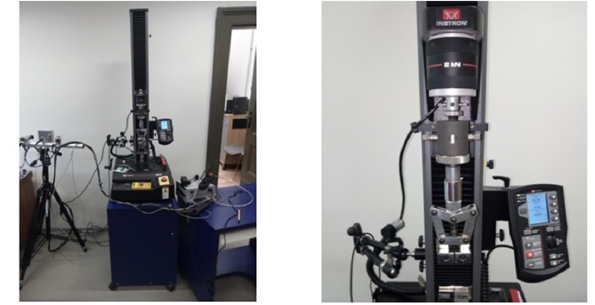
Figure 5: Test rig Instron model 5944